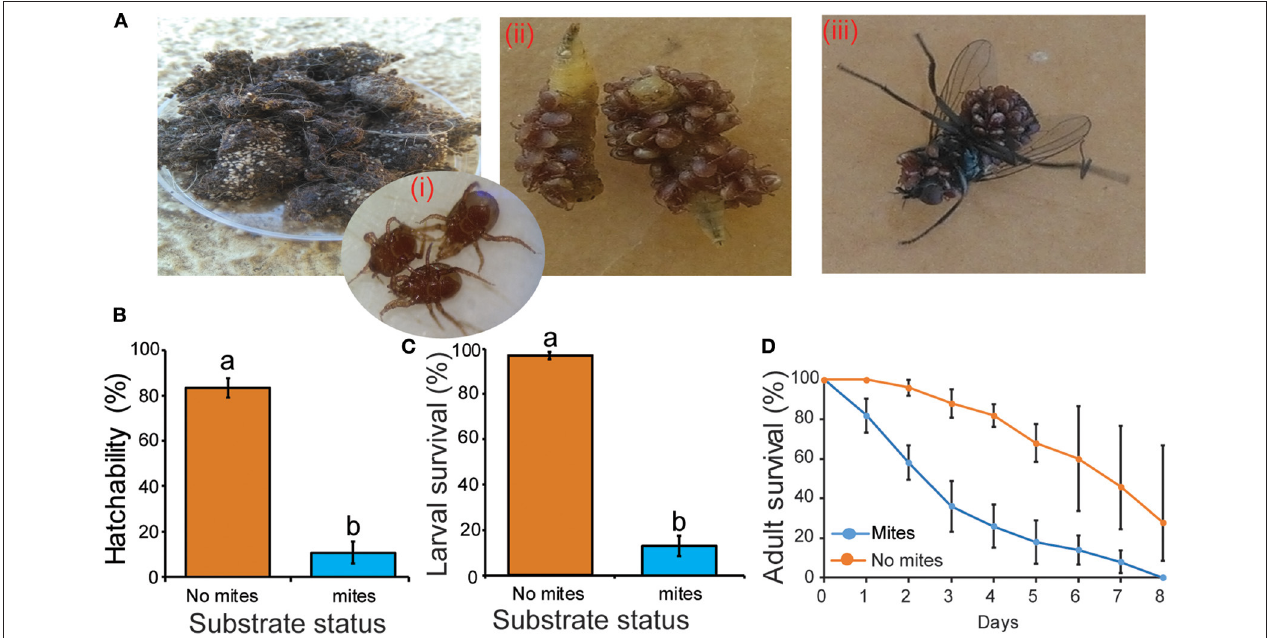
FIGURE 5 | Effect of the mite M. muscaedomesticae on S. calcitrans survival. (A) Adult M. muscaedomesticae (i) aggregated on dead S. calcitrans larvae as well as (ii) dead and (iii) live adult S. calcitrans . (B,C) Bar charts showing hatchability of S. calcitrans eggs (B) and larval survival (C) on substrates with and without mites (GLM with binomial distribution followed by the analysis of deviance test, P < 0.05, n = 10). (D) Kaplan-Meier curve showing survivorship over time in adult of S. calcitrans with or without mite infestation (Mantel-Cox log-rank χ 2 test, P < 0.05, n = 5). Error bars indicate the standard error of the mean. Treatments with different lowercase letters are significantly different from each